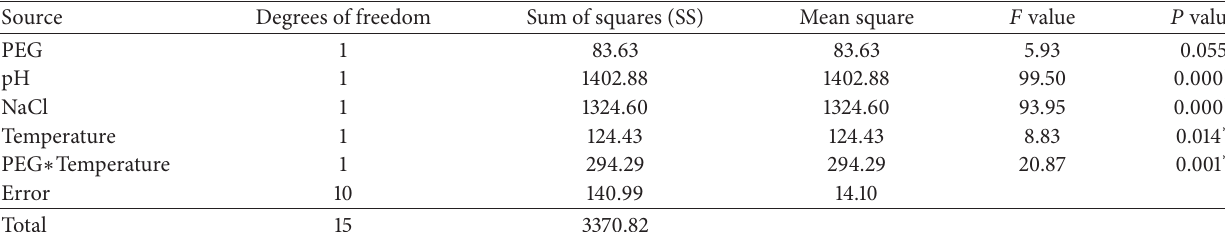
Table 3: ANOVA table for fFD.